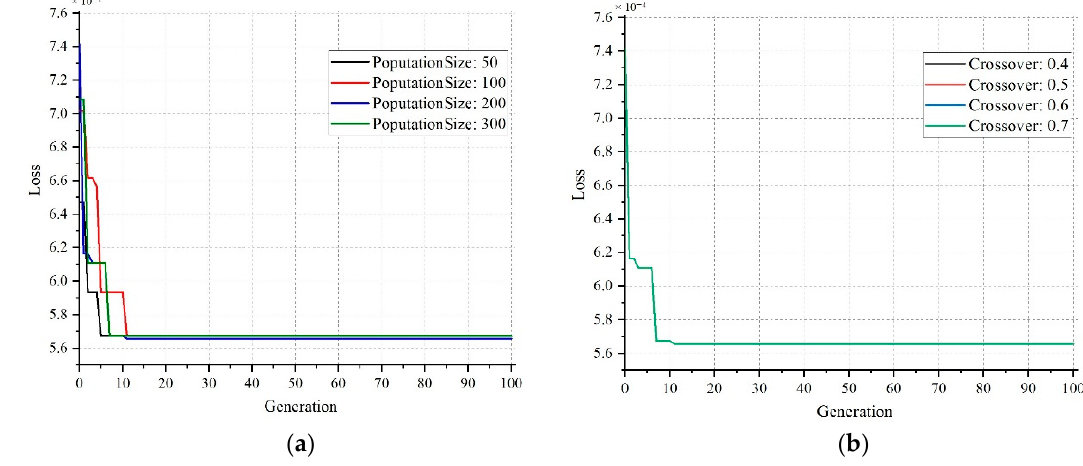
Figure 9. Effect of varying the population size ( a ) and crossover probability ( b ). Figure 9. E ff ect of varying the population size ( a ) and crossover probability ( b